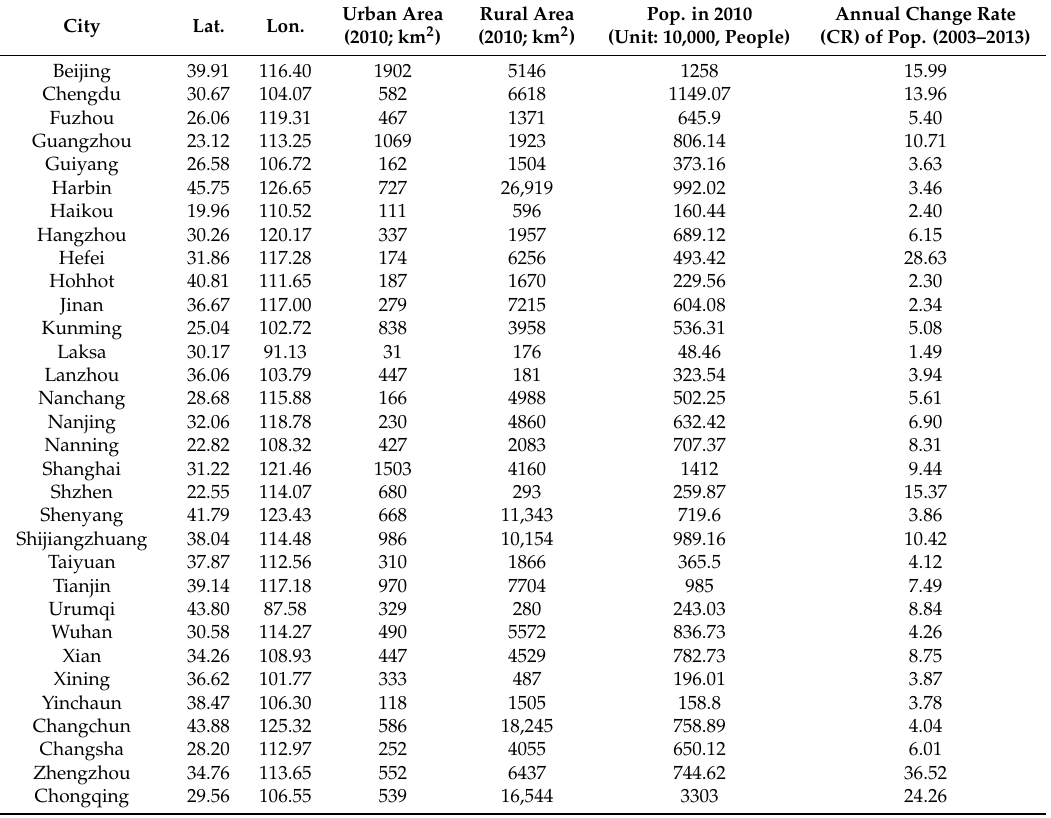
Table 1. Summarized information for selected cities examined in this research. City